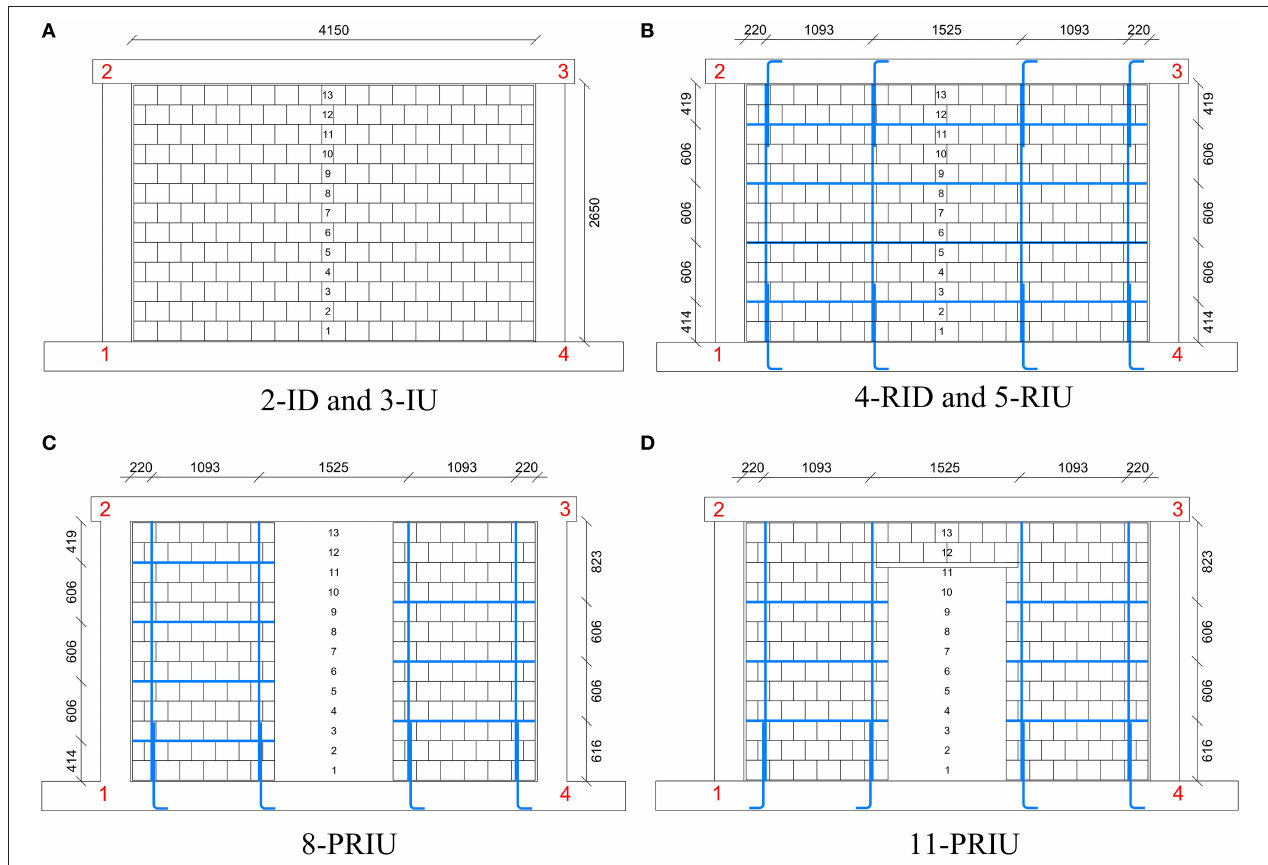
FIGURE 3 | Fully filled frames with unreinforced masonry (A) ; fully filled frames with reinforced masonry (RM) (B) ; partially RM filled frame with opening (C) ; partially RM filled frame with opening and lintel (D) .